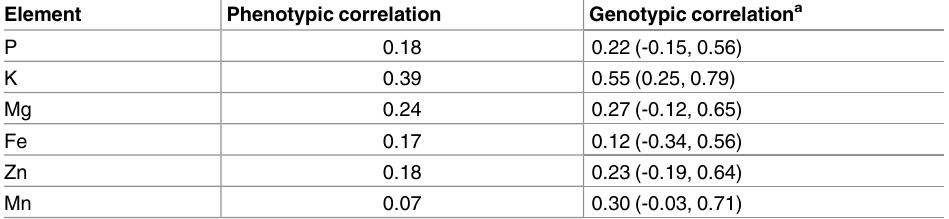
a Numbers inside parentheses correspond to the 95% confidence